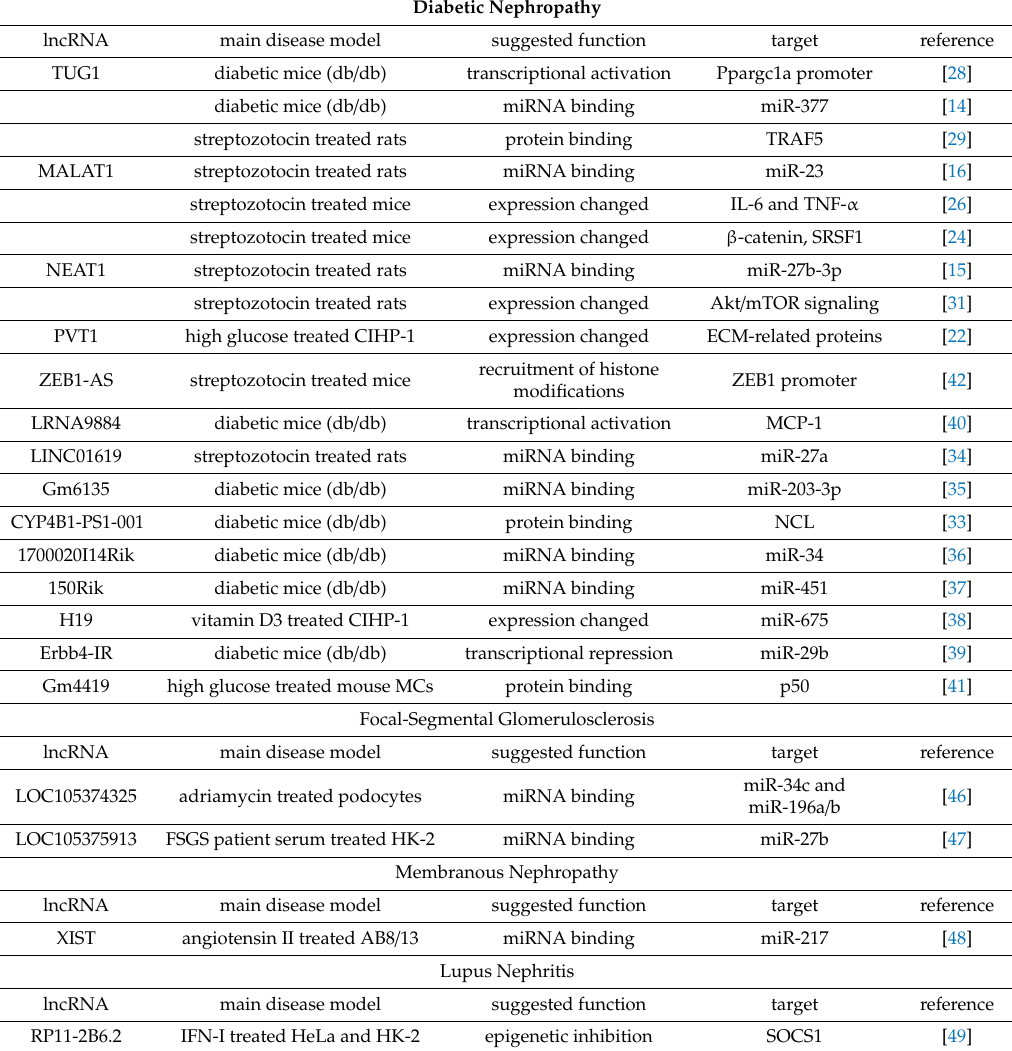
Table 1. LncRNAs involved in glomerular